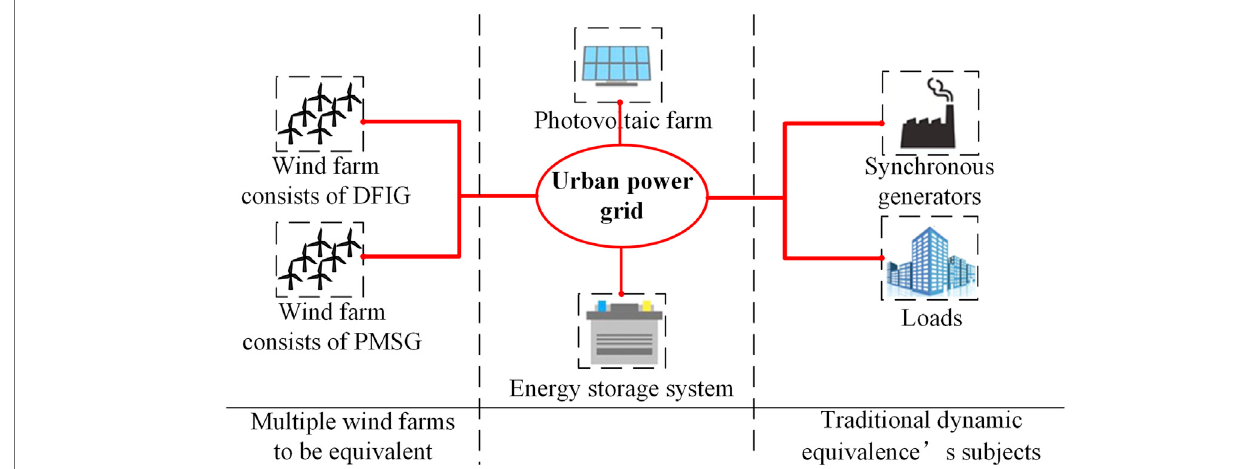
FIGURE 1 | Schematic structure of WFs in urban power gird.